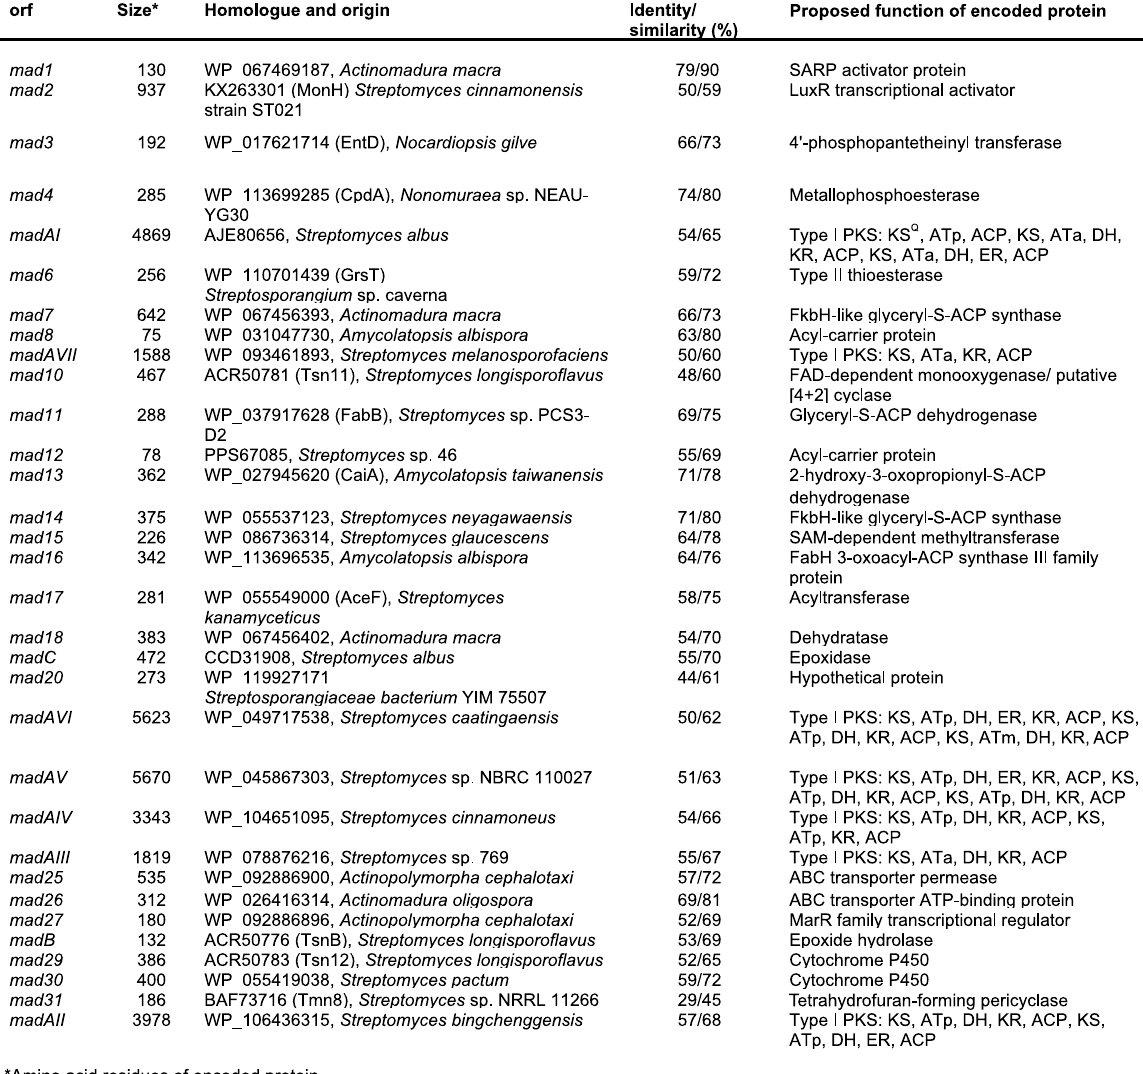
Fig 2. Predicted functions of genes in the mad gene cluster. ATa = malonyl-CoA selective AT domain (acetate unit). ATp = ( 2S )- methylmalonyl-CoA selective AT domain (propionate unit). ATm = predicted ( 2R )-methoxymalonyl-ACP selective AT domain.